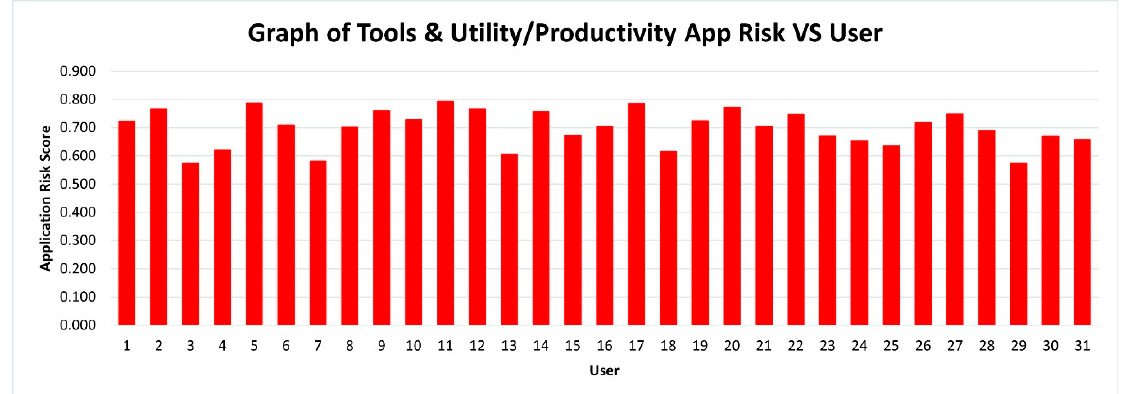
Figure 5. Graph of Tools & Utility/Productivity app risk vs. users.